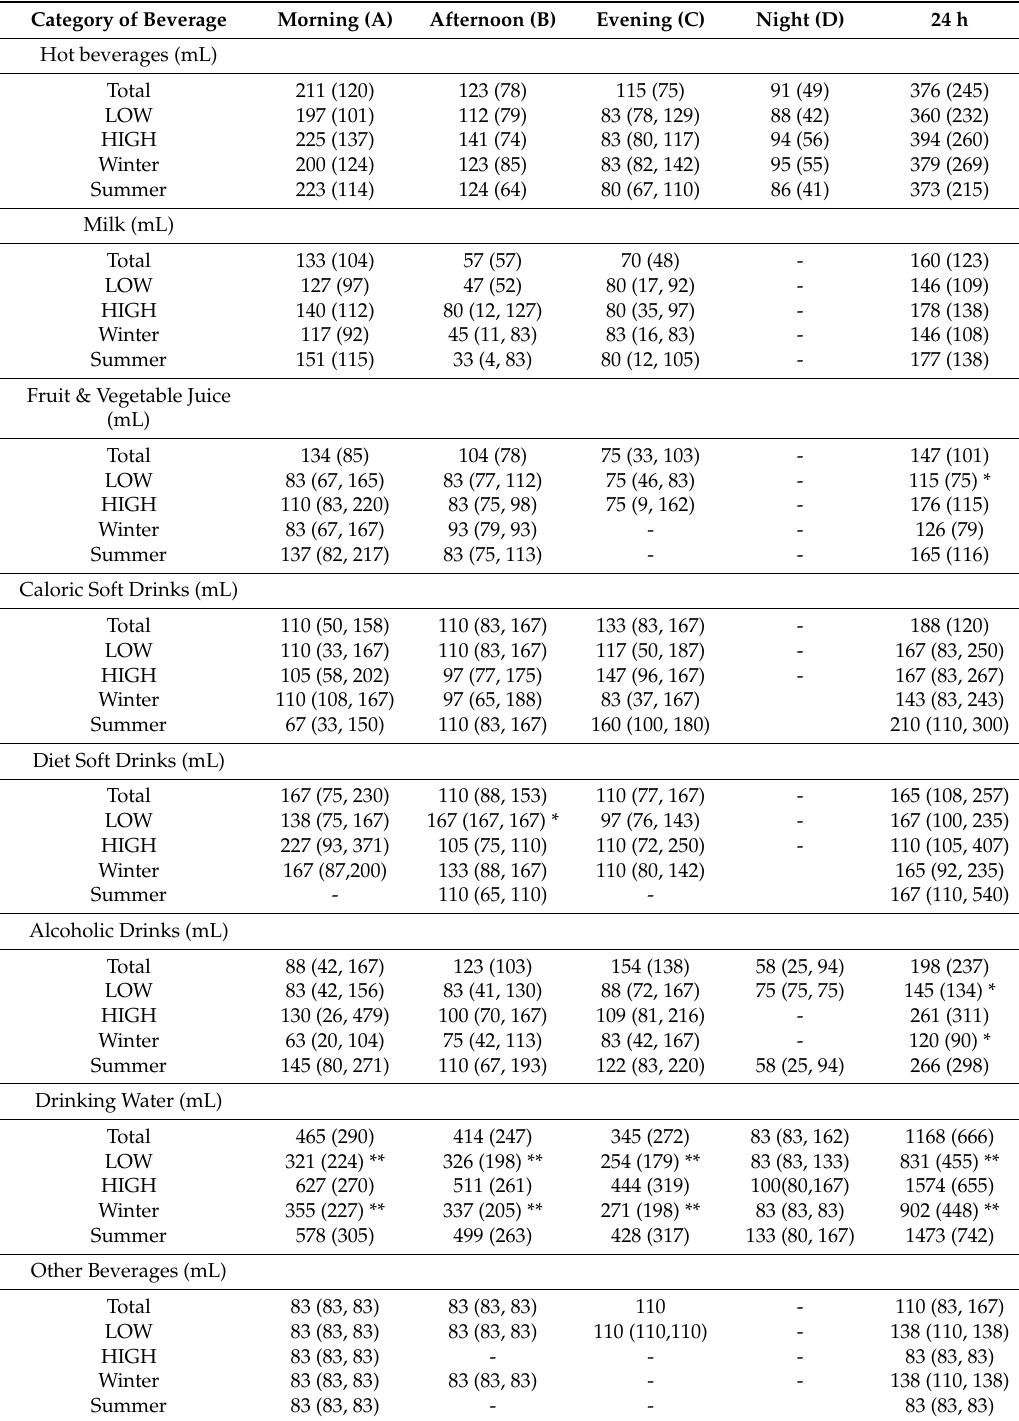
Table 1. Category of beverages consumed in each 6 h period and over a 24 h period for the total sample, LOW drinkers (subjects with a total water intake lower than European Food Safety Authority (EFSA) dietary references), HIGH drinkers (subjects with a total water intake higher than EFSA dietary references), winter and summer